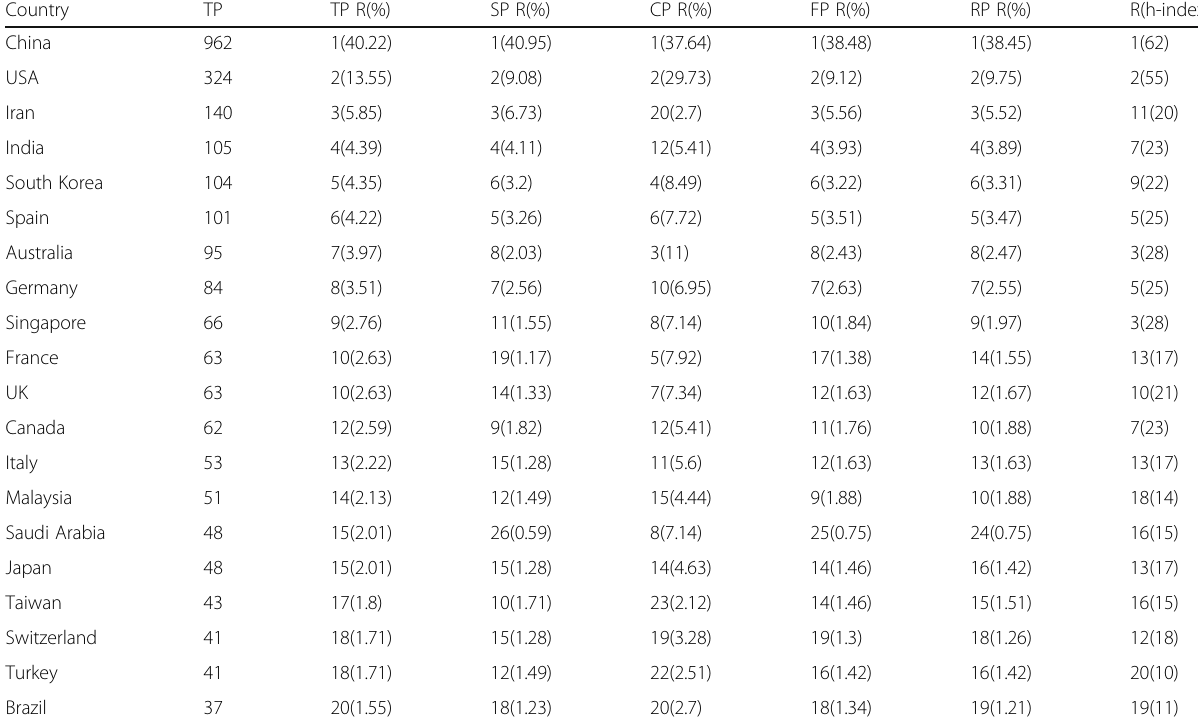
Table 1 Top 20 productive countries/territories during 1997 –